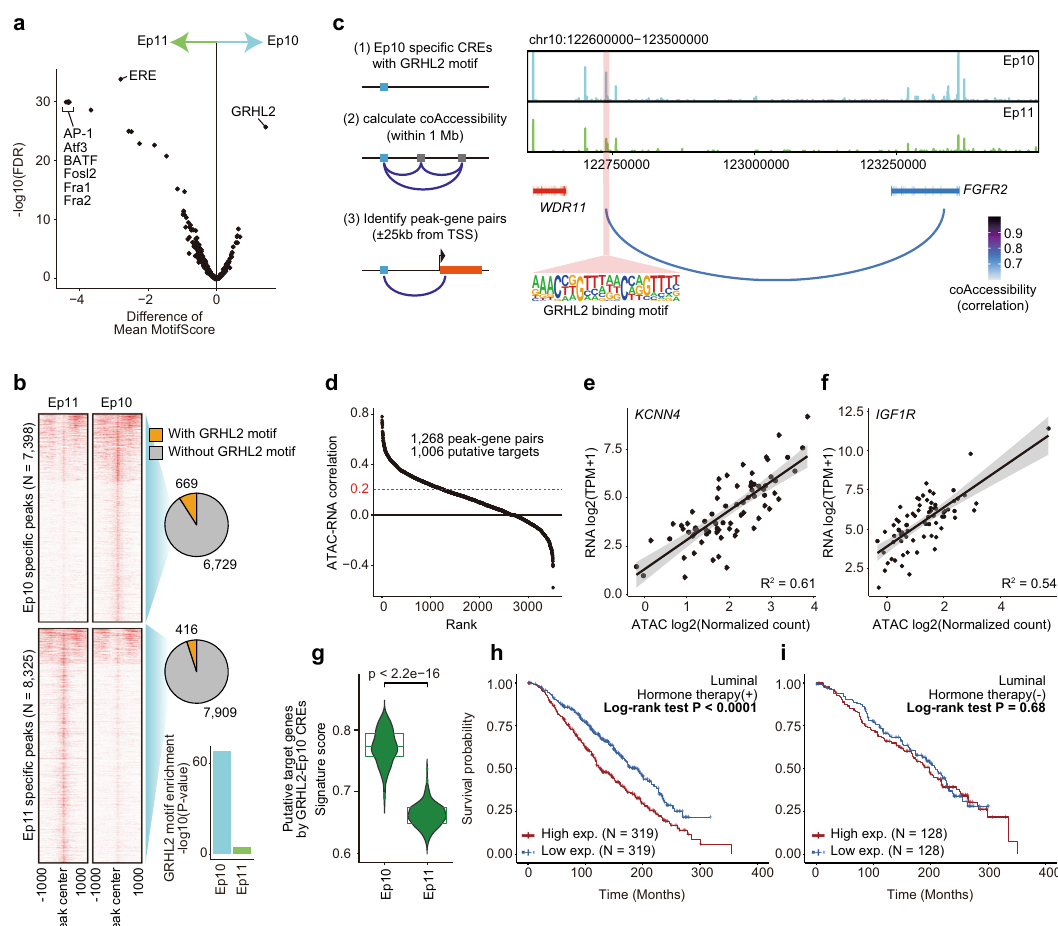
Fig. 5 GRHL2 was associated with less ER dependency leading to the intratumor heterogeneity of a single luminal tumor. a Volcano plot representing differential motif enrichment between Ep10 and Ep11 from a single luminal tumor. b Heatmap of aggregated ATAC-seq signal in a 2 kb window, divided according to a signi fi cantly higher signal in Ep11 or in Ep10. Pie charts show the numbers of Ep10- or Ep11-speci fi c peaks with or without GRHL2-binding motifs. The bar plot represents hypergeometric tests of GRHL2 motif enrichment in each CRE set. c Schema for identifying peak-gene associations (left), and genome accessibility track of the FGFR2 region with peak coaccessibility (right). The red band indicates the Ep10-speci fi c element with GRHL2 motif potentially interacting FGFR2 coding region. d Pearson ’ s correlation between TCGA-BRCA ATAC-seq normalized counts and RNA-seq transcripts per million of each peak-gene pair. e , f RNA-seq gene expression of KCNN4 in e or IGF1R in f and normalized ATAC-seq signal of paired peaks in 74 TCGA-BRCA samples. Each dot represents each patient. g Signature scores of putative target genes by Ep10-speci fi c CREs with GRHL2 motifs in Ep10 ( N = 281) and Ep11 ( N = 327). Wilcoxon rank-sum test was used for signi fi cant analysis ( p < 2.2e-16). h , i Kaplan – Meier analysis of overall survival of the METABRIC ER + HER2 − patient cohort ( n = 1,355) with ( n = 968, h ) or without ( n = 387, i ) hormone therapy strati fi ed by putative GRHL2 target genes; top 33% versus the bottom 33%, mean of Z -score of